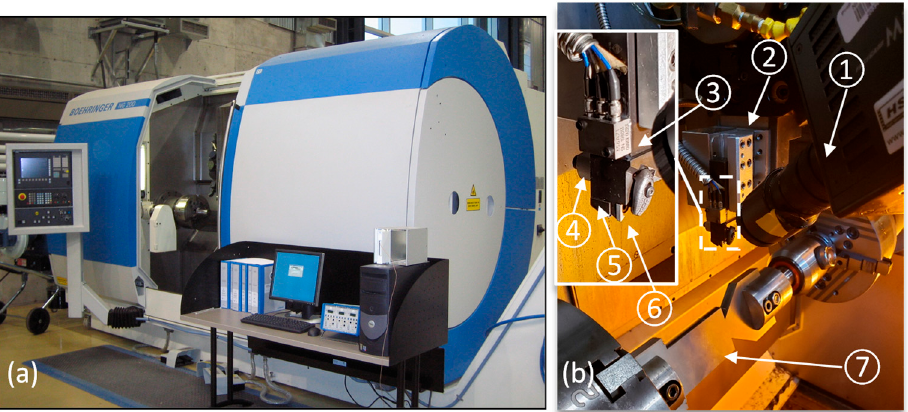
Figure 2. ( a ) Boehringer NG200 Turning Centre and ( b ) experimental setup. ① High-speed camera, ② Dynamometer, ③ Accelerometer, ④ AE sensor, ⑤ Cutting tool, ⑥ Cutting insert, and ⑦